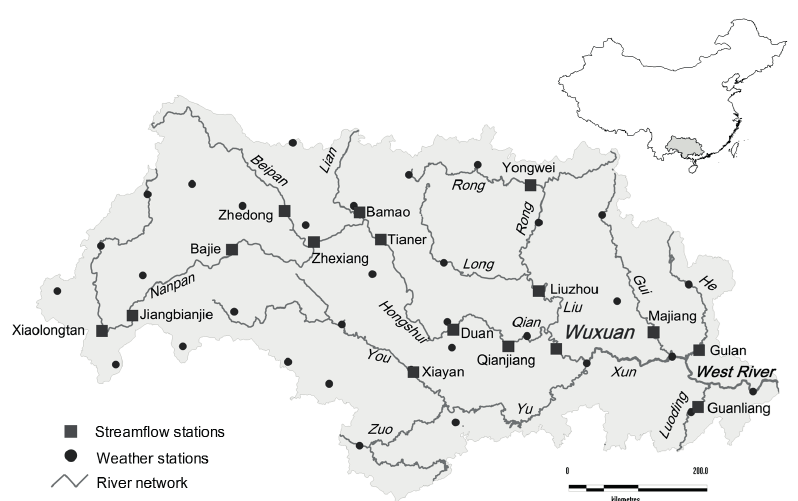
Fig. 2 Meteorological and streamflow stations in the West River